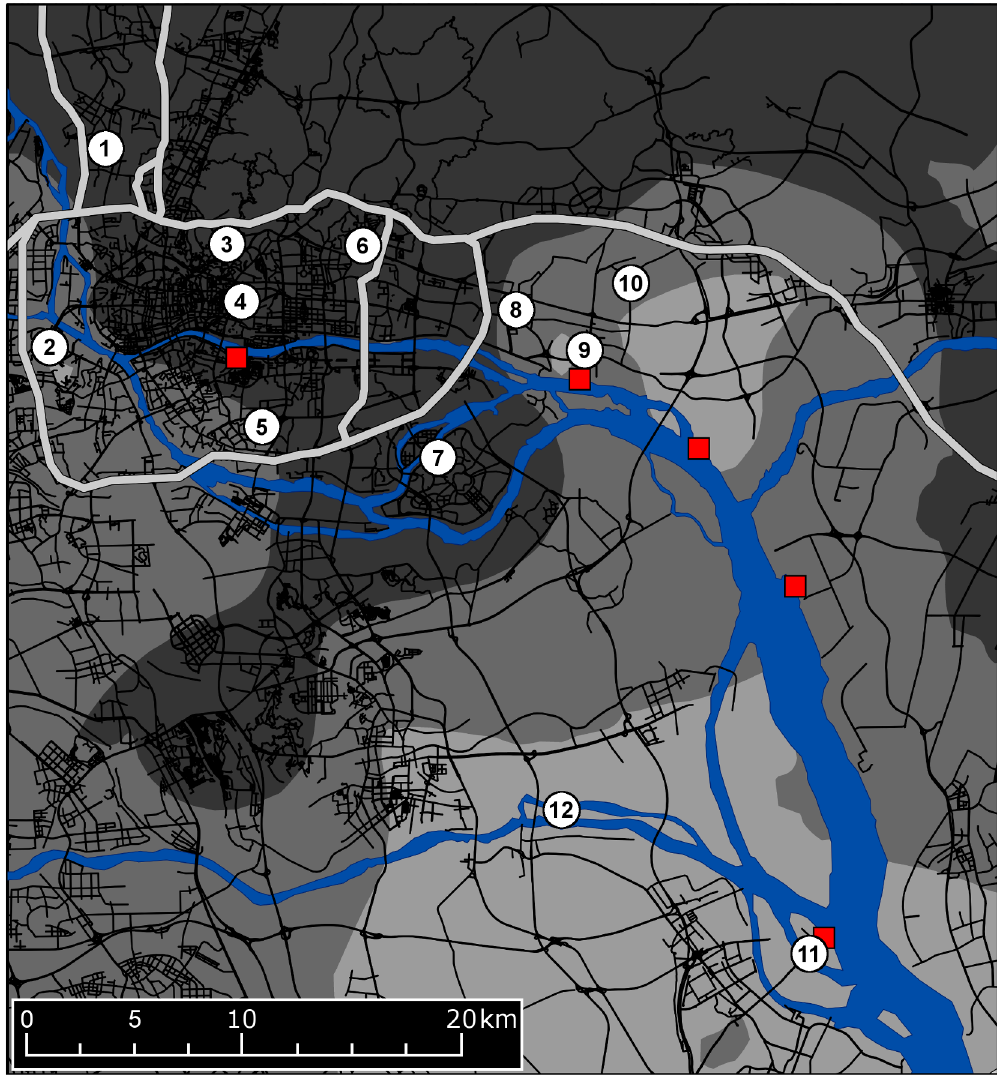
Fig 1. Sampling locations and study site geography. The numbered white circles show the 12 sample sites. The red squares show the locationsof the five shippingterminals. The rivers and estuary are shown in blue. High- capacity highwaysare plotted as wide, light grey lines, while the greater highwaynetwork is in black. The background shadingdescribesthe averageinterpolatedBreteau Index score: 0–2 (dark grey); 2–4 (grey); 4–6 (light grey). The underlying road network is derived from the Chinese"Highways" shapefilemade availableby MapCruzin. com and OpenStreetMap.orgunder the Open DatabaseLicense[https://opendatacommons.org/licenses/odbl/1.0/].